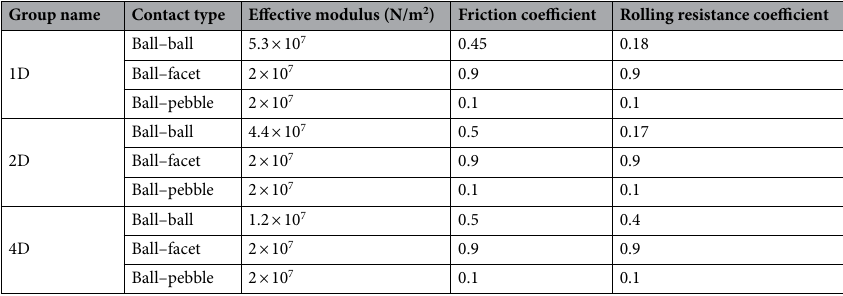
Table 1. Summary of calibrated contact model parameters.